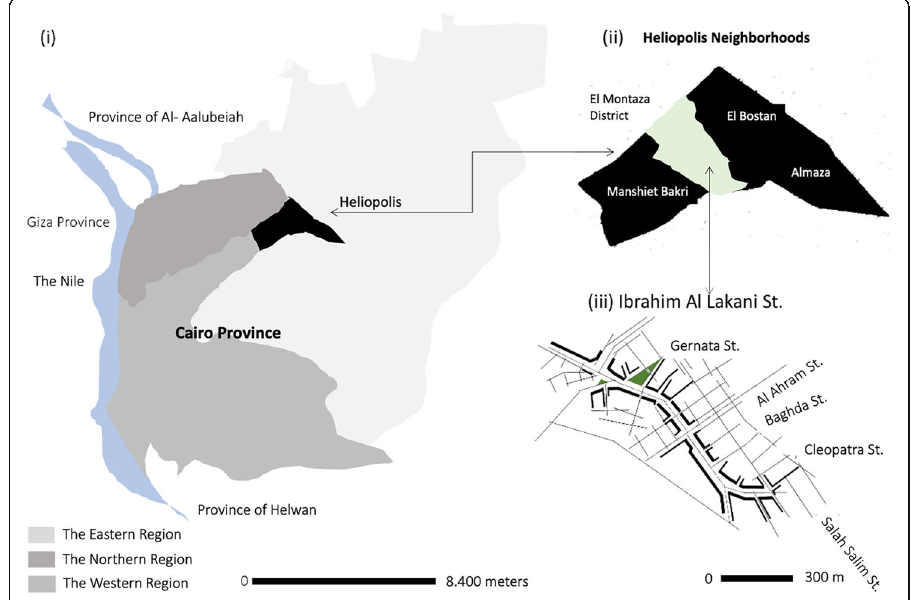
Fig. 1 The state of the case study: (i) Heliopolis districts in Cairo, (ii) four neighbourhoods of Heliopolis districts and (iii) the